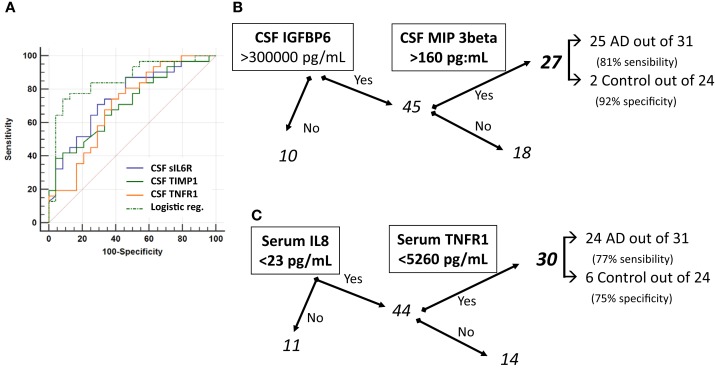
Area under ROC curve (AUC) of Tau, p-Tau, and sTNFR-I. ROC curves (A) of the three most efficient biomarkers for AD diagnosis sIL-6R, TIMP-1, and sTNFR-I were plotted along with their combination (logistic regression, see text). The classification tree for CSF biomarkers (B) defined as AD samples those with IGFBP6 >300,000 pg/mL and MIP-3beta >160 pg/mL. Using serum biomarkers (C), the criteria selected for AD diagnosis was: IL8 <23 pg/mL and TNFR-I <5260 pg/mL.